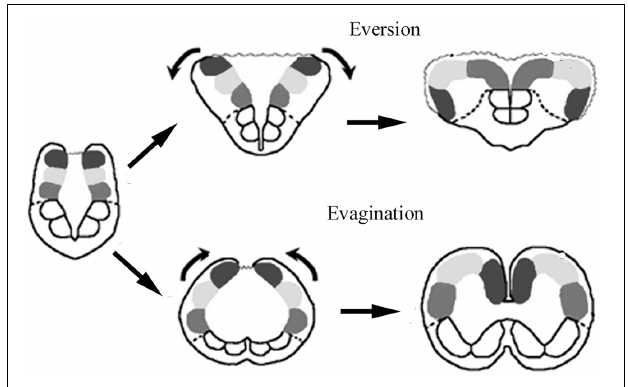
FIGURE 2 | Sketch of brain evagination characteristic of Sarcopterygii-Tetrapoda, and eversion characteristic of Actinopterygii. Solid spots: pallial subdivisions, empty spots: subpallium, dotted line: their border, wavy line: the thin wall of ventricle.